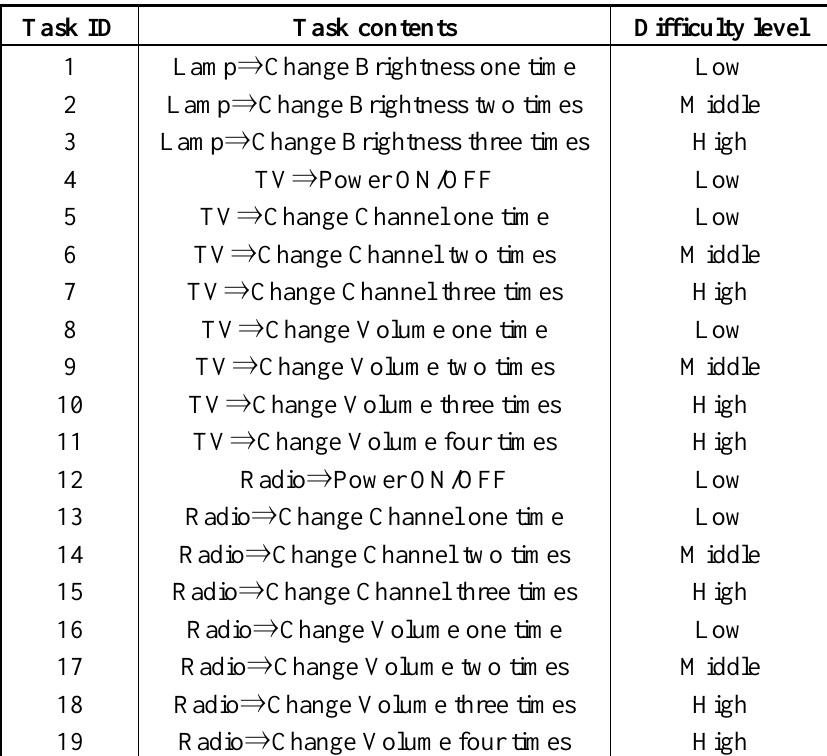
Table 2. Task list for evaluation